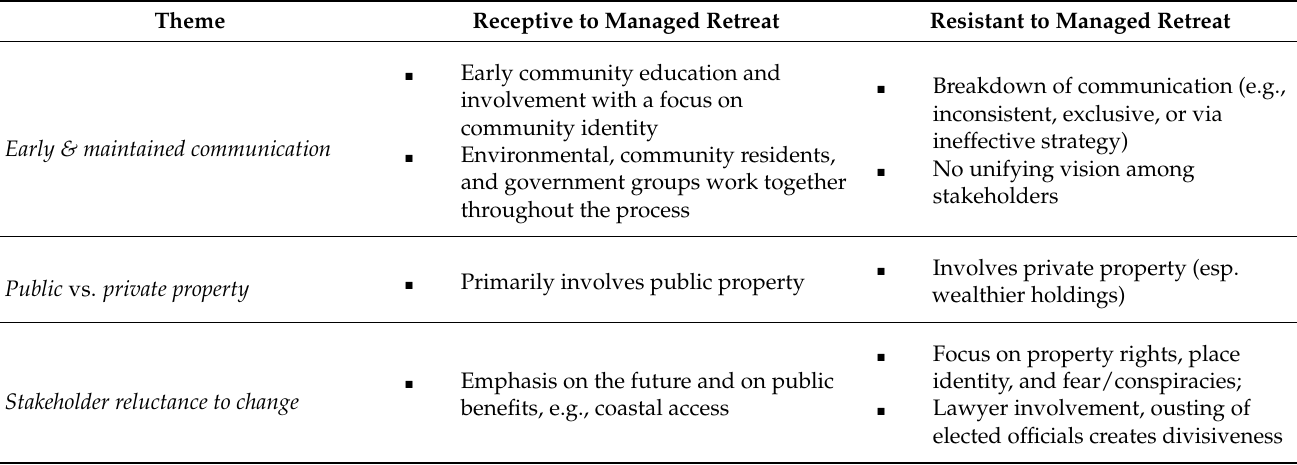
Table 2. Commonalities within cases of receptiveness and resistance toward managed retreat across emergent themes.